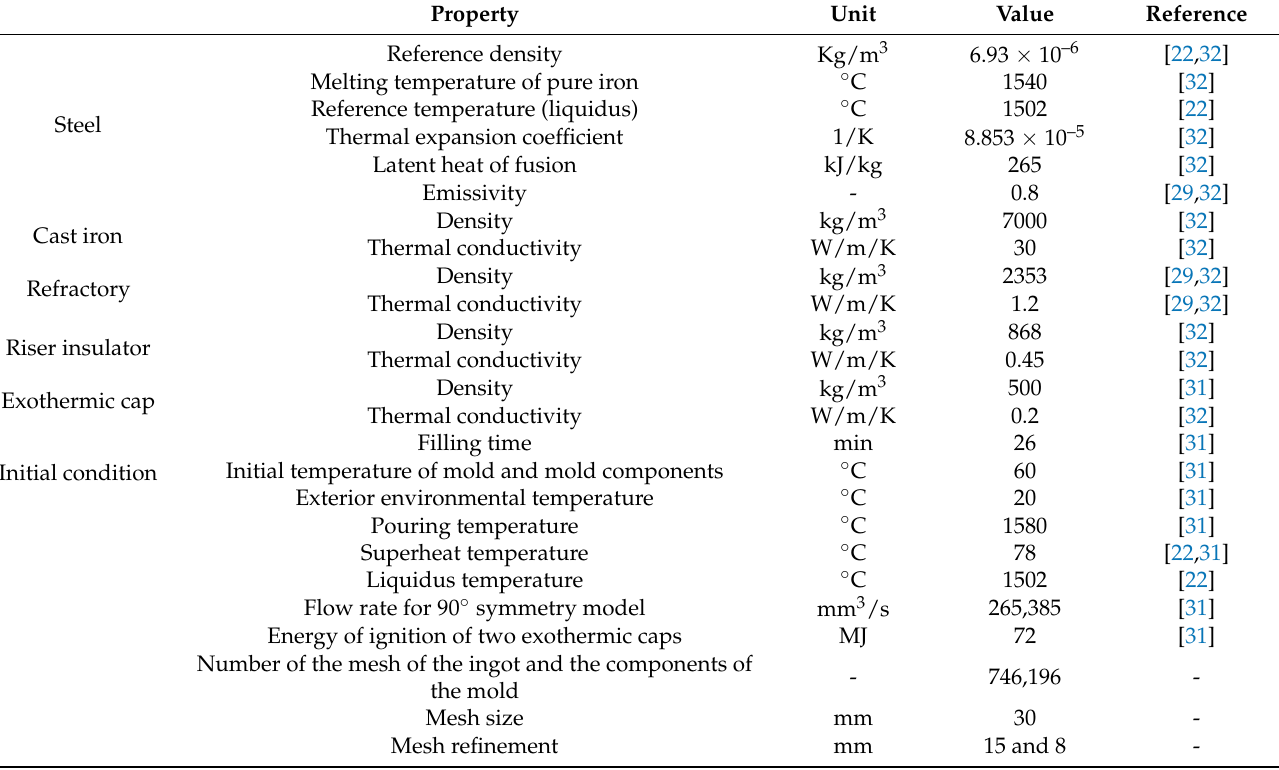
Table 2. Input parameters for the